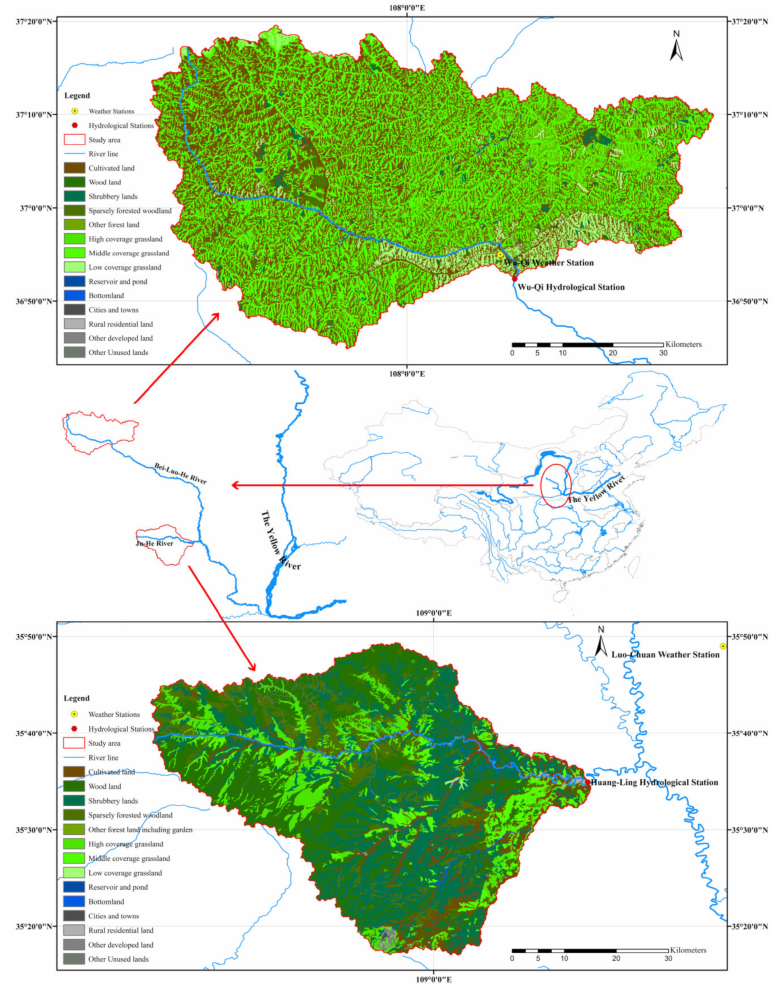
Figure 1. Geographical attributes of the study